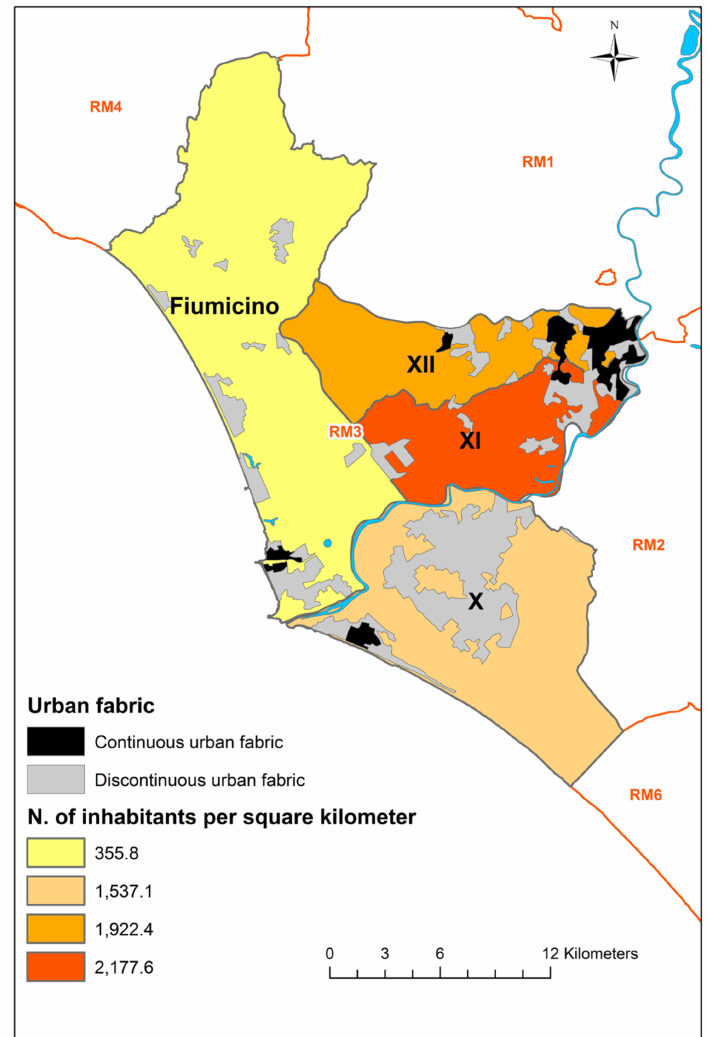
Figure 1. Human population density and urban fabric of the study area (RM followed by a number refers to the LHU of Rome). Layers sources: Corine Land Cover (CLC) 2018 (https://land.copernicus. eu/pan-european/corine-land-cover/clc2018?tab=download, accessed on 25 August 2021); Rome districts (http://websit.cittametropolitanaroma.it/Download.aspx, accessed on 25 August 2021); Ital- ian municipalities (https://www.istat.it/it/archivio/222527, accessed on 25 August 2021); Resident population data sources: http://dati.istat.it/Index.aspx?DataSetCode=DCIS_POPRES1#, accessed on 25 August 2021 (Fiumicino municipality), https://www.comune.roma.it/web/it/i-numeri-di- roma-capitale.page, accessed on 25 August 2021 (Districts X, XI and